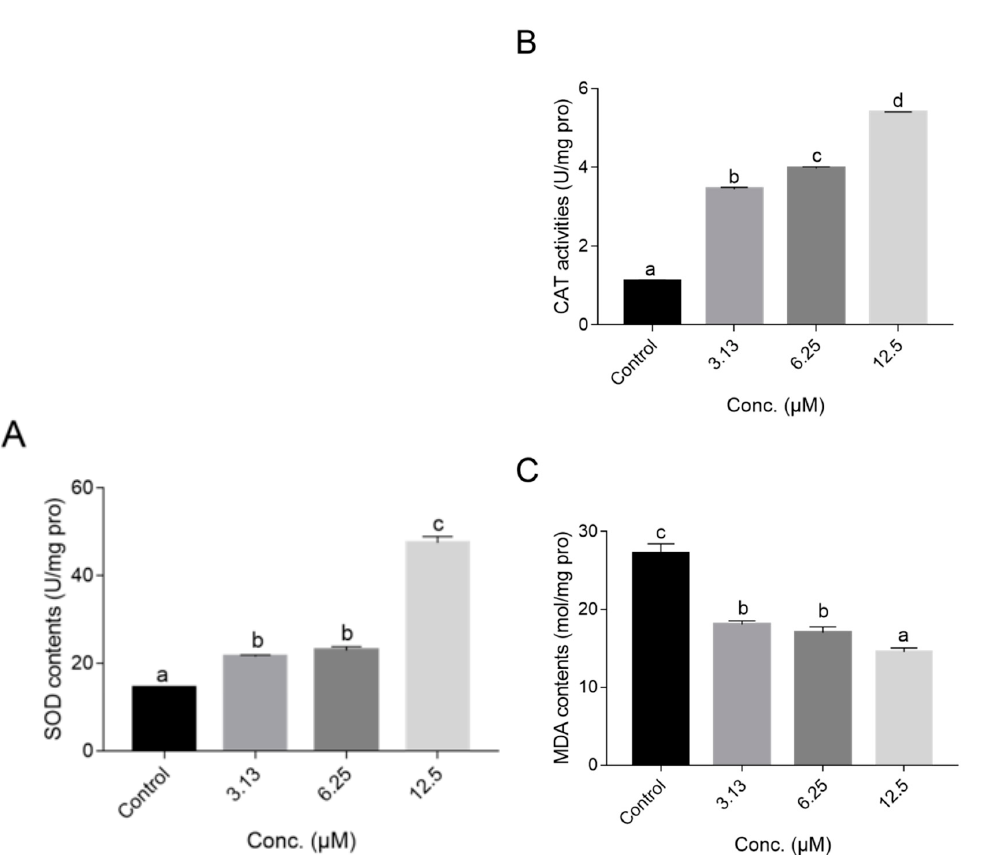
Figure 8. E ff ect of NOB on antioxidant enzymes in C. elegans . The activities of relative antioxidant enzymes: SOD ( A ) and CAT ( B ), and the malondialdehyde (MDA) content ( C ) in C. elegans after treatment with indicated concentrations of NOB. Data are shown as mean ± SD, n = 3. Bars with di ff erent letters indicated statistical significance ( p < 0.05).